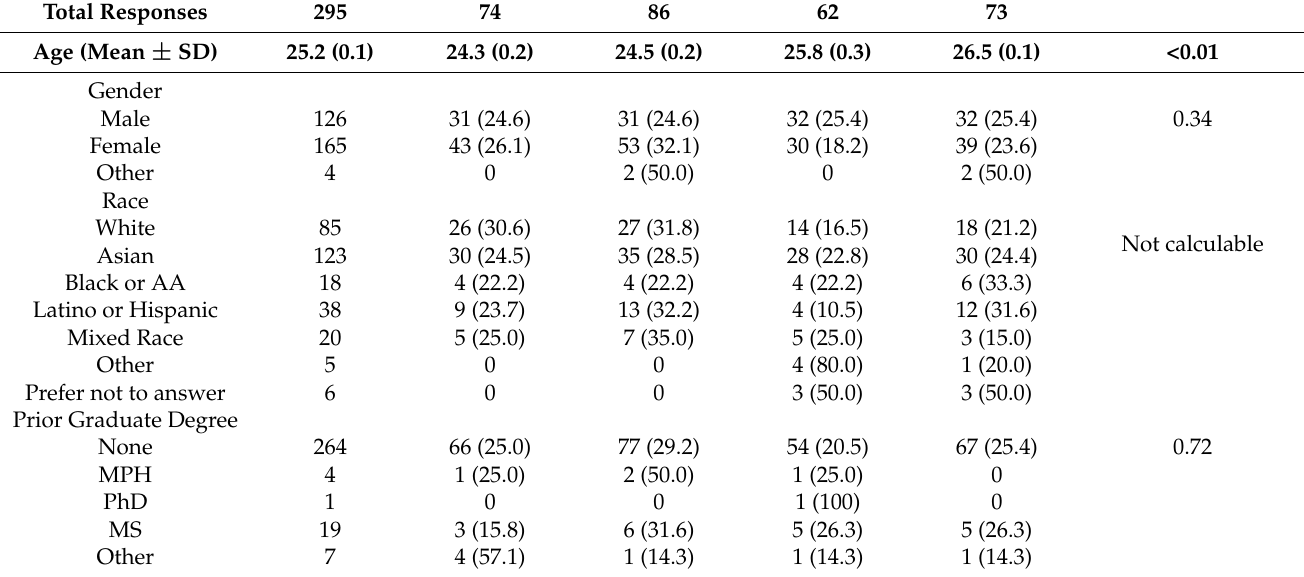
Table 1. Demographics of Study